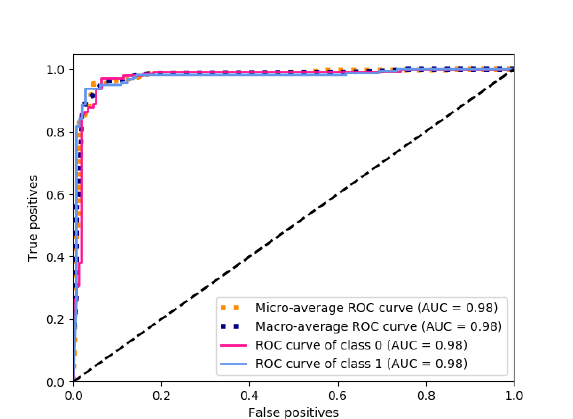
Figure 4. Receiving operating characteristics (ROC) curves obtained with the average performance of the ANN. AUC: area under the